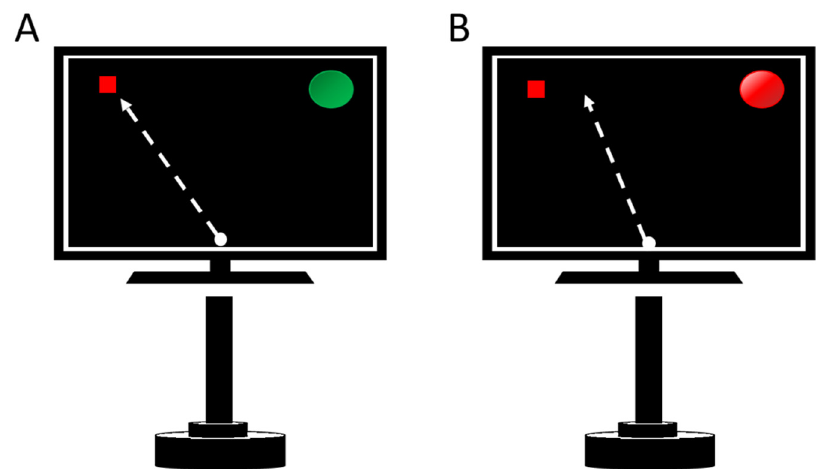
Figure 1. ( A ) Visual information when the participant hit the target; ( B ) Visual information when the participant did not hit the target. The ball trajectory was occluded during the experiment; the trajectory is shown in the figure as a dotted line only for the description of the task.